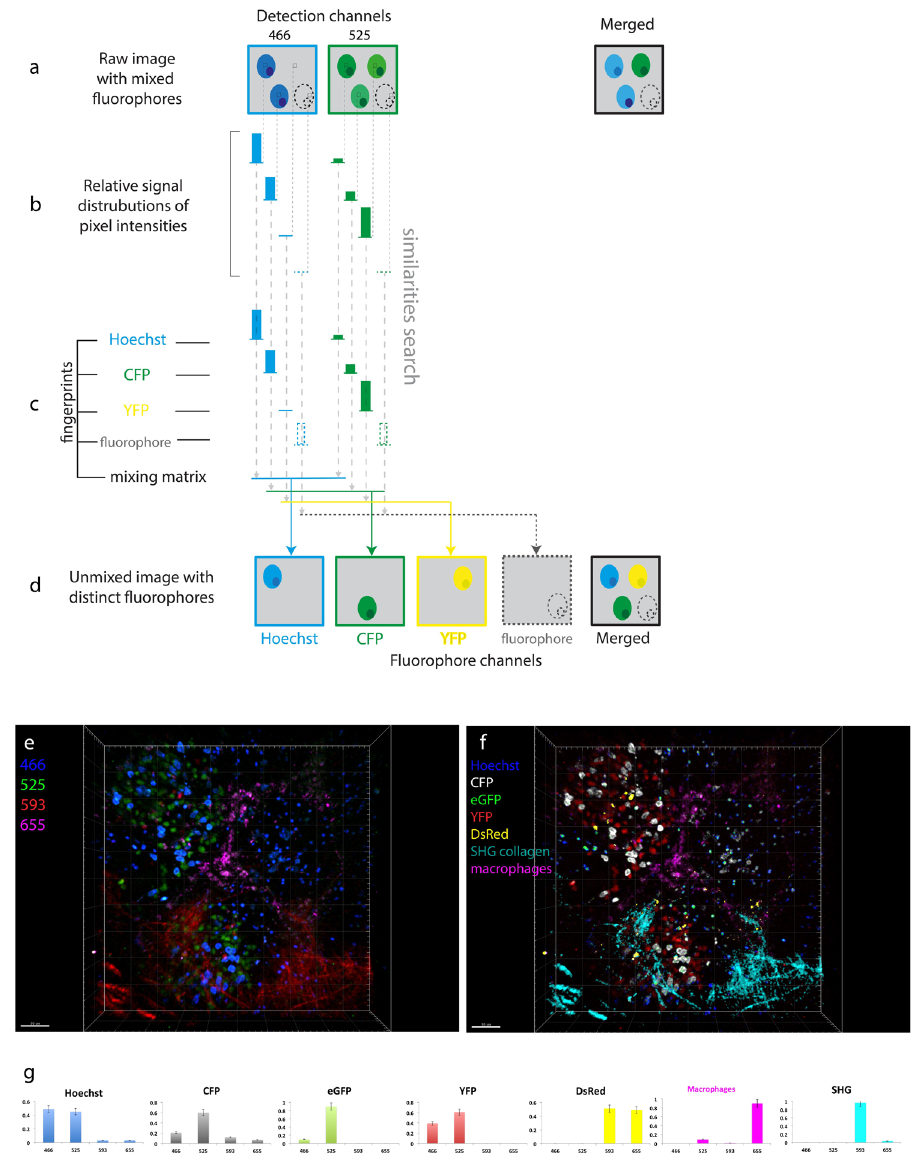
Figure 5. Similarity unmixing in the underdetermined case in vivo . ( a – d ) Schematic of the similarity algorithm in the underdetermined condition. ( a ) Raw images of cellular objects show crosstalk in two detection channels. The merged image illustrates color ambiguity of cells. The dashed contour represents a cell expressing any additional fluorophore. ( b ) The algorithm extracts a relative signal distribution from two channels pixels by pixel. The pixels containing the cellular fluorescent signal indicate signature of ambiguous fluorophores. ( c ) The fingerprints of Hoechst, CFP, YFP are measured at the single color condition. The algorithm searches for similarities between the signatures of undefined fluorophores from ( b ) and the known fingerprints channel by channel (dashed arrows). The key point for color separation in the underdetermined condition is the different ratios between the fingerprint elements of various fluorophores. The number of fluorophores is not limited unless the difference between their fingerprints is negligible (dashed bars of the fluorophore fingerprint). ( e ) Raw three-dimensional view of murine lymph node imaged on four channels. The lymphocytes are labeled with one of five fluorophores: Hoechst, CFP, hrGFP, YFP, DsRed. ( f ) Unmixed image of ( e ) containing seven color parameters (five fluorescent colors, second harmonic generation (SHG) from collagen and autofluorescence from macrophages). ( g ) The fingerprints of Hoechst, CFP, hrGFP, YFP, DsRed, macrophages and SHG. Scale bars, 50 μ